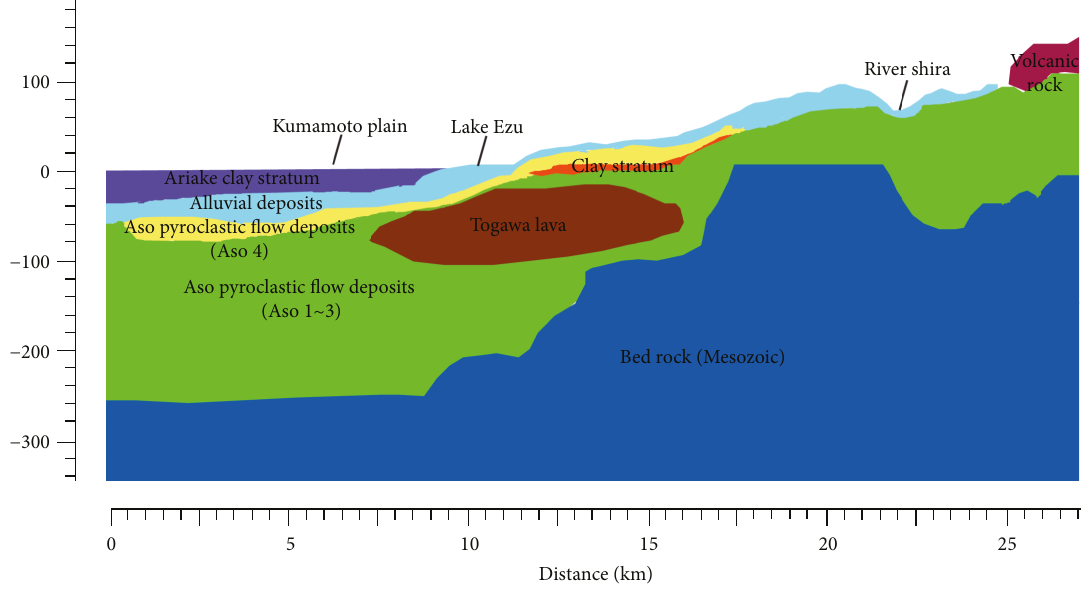
Figure 2: Geological section along line AA ’ .